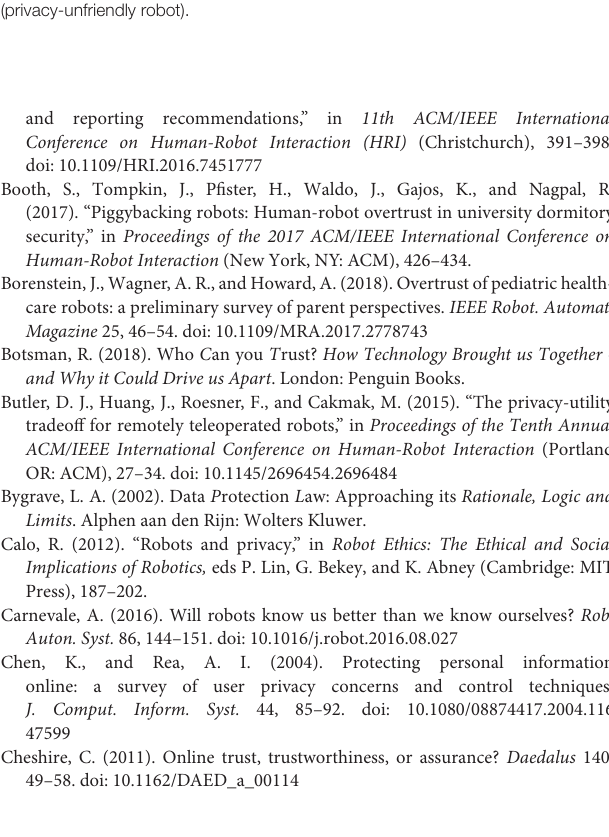
Supplementary Figure 1 | Experimental vignette for low privacy risk scenario (privacy-friendly robot). Supplementary Figure 2 | Experimental vignette for high privacy risk scenario (privacy-unfriendly